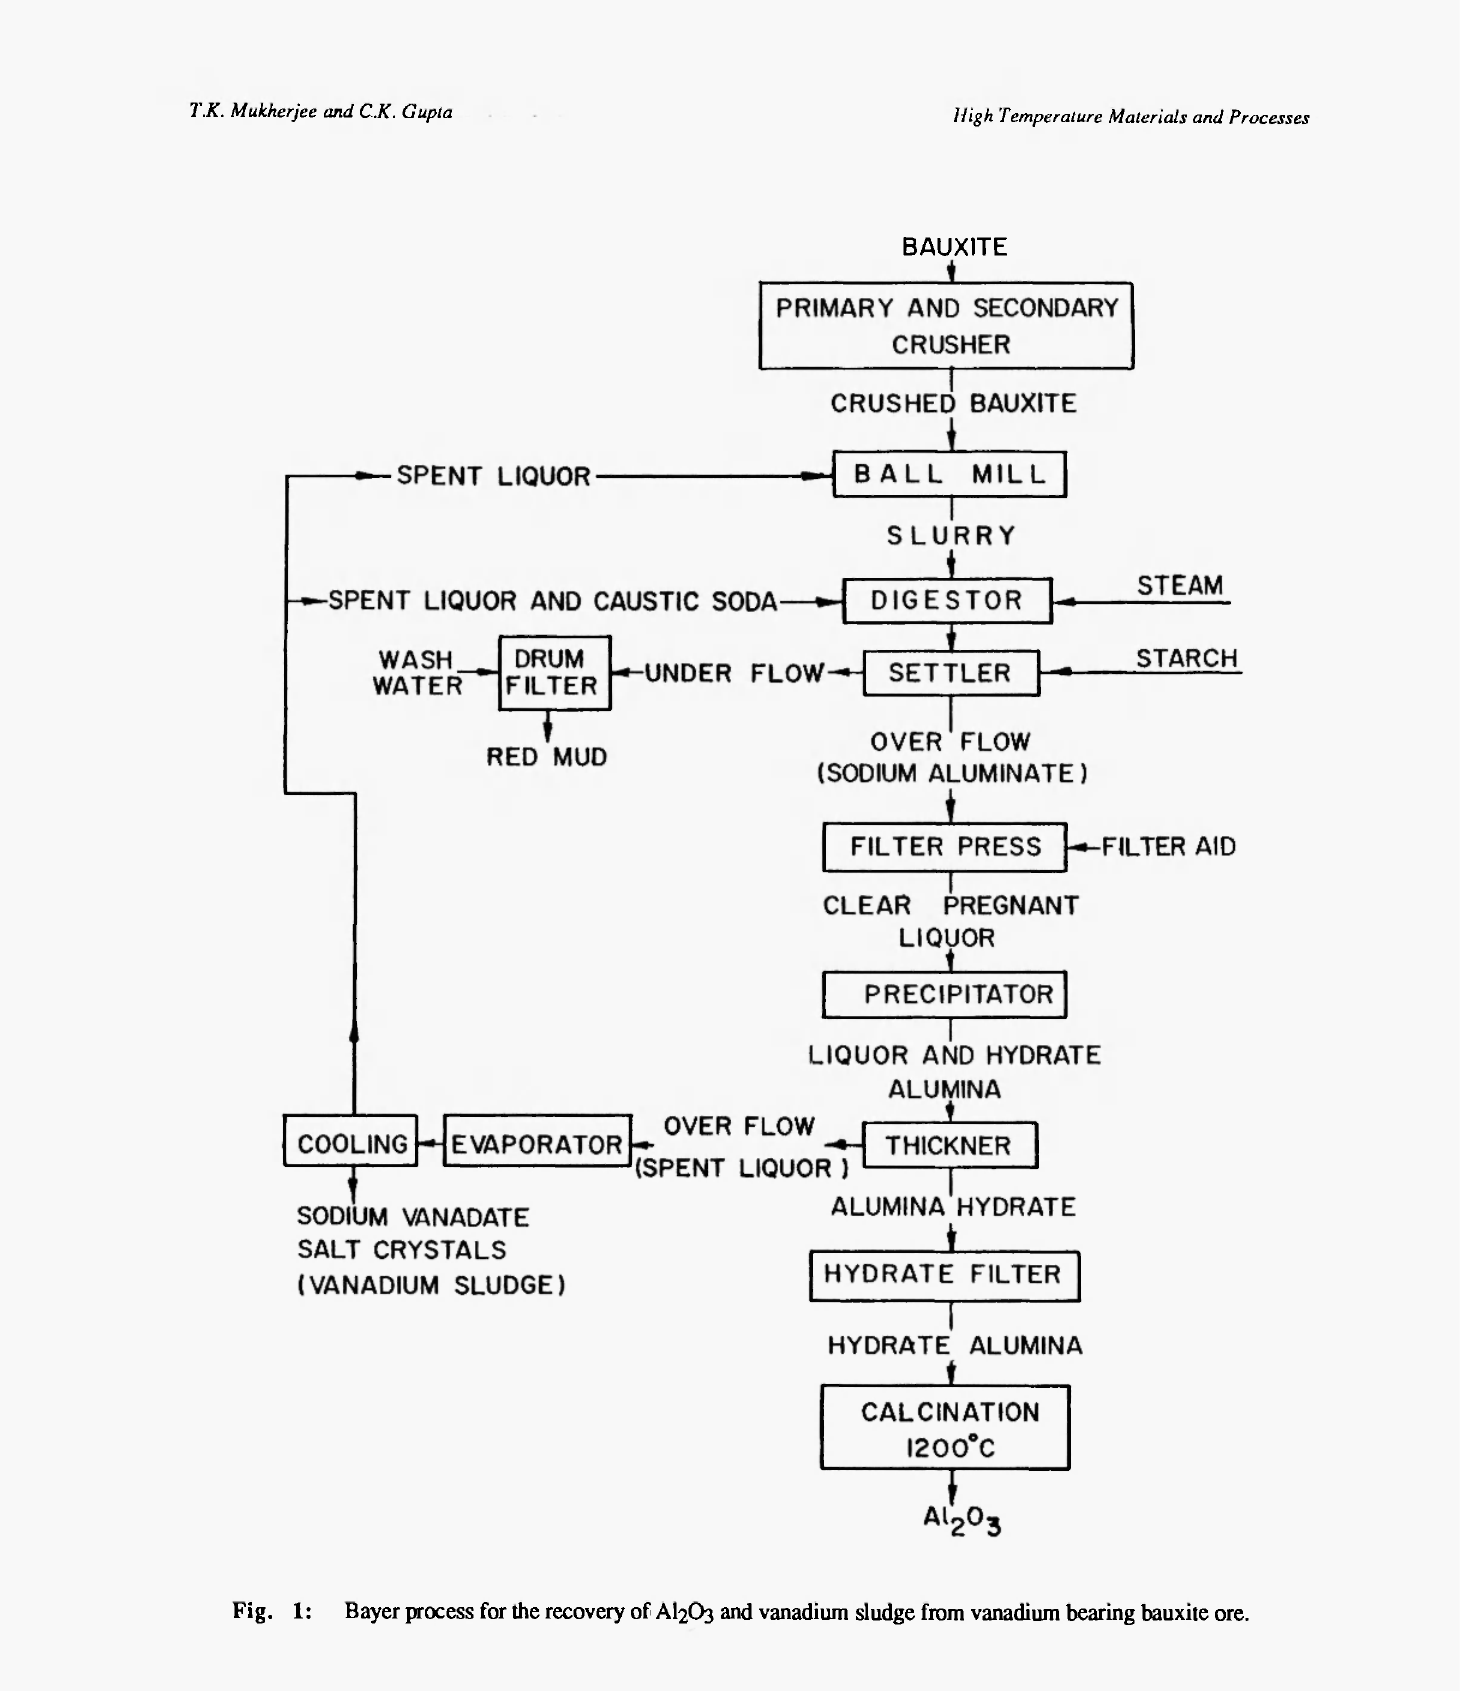
Fig. 1: Bayer process for the recovery of AI2O3 and vanadium sludge from vanadium bearing bauxite ore.